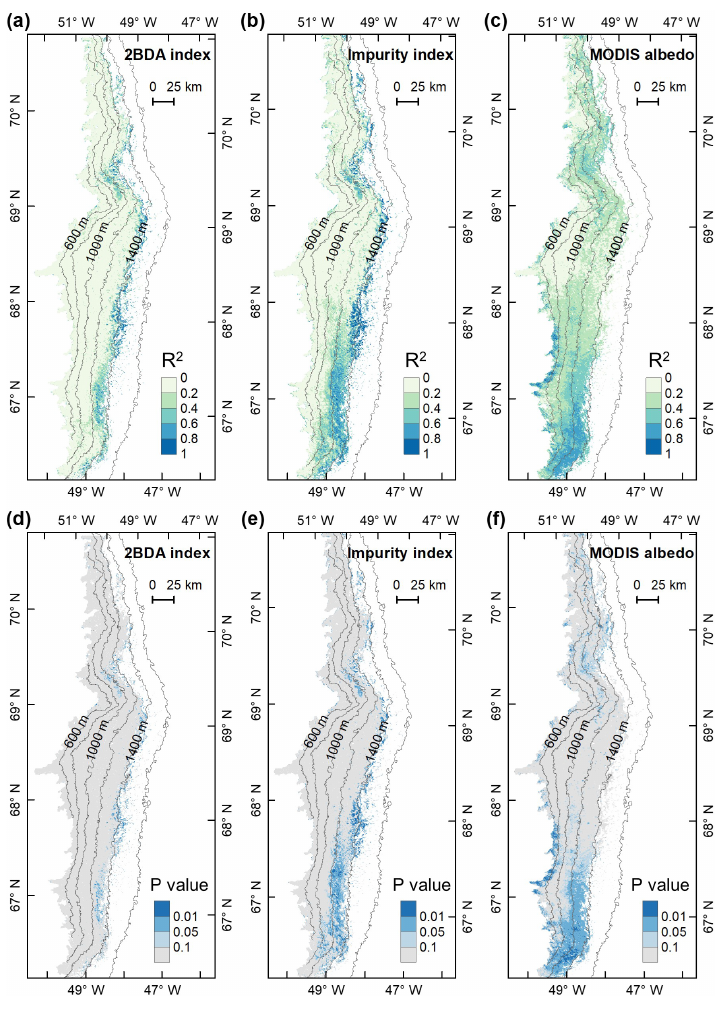
Figure A5. R 2 and P values for the interannual trends of the 2BDA index, impurity index, and MODIS albedo from 2004 to 2011.